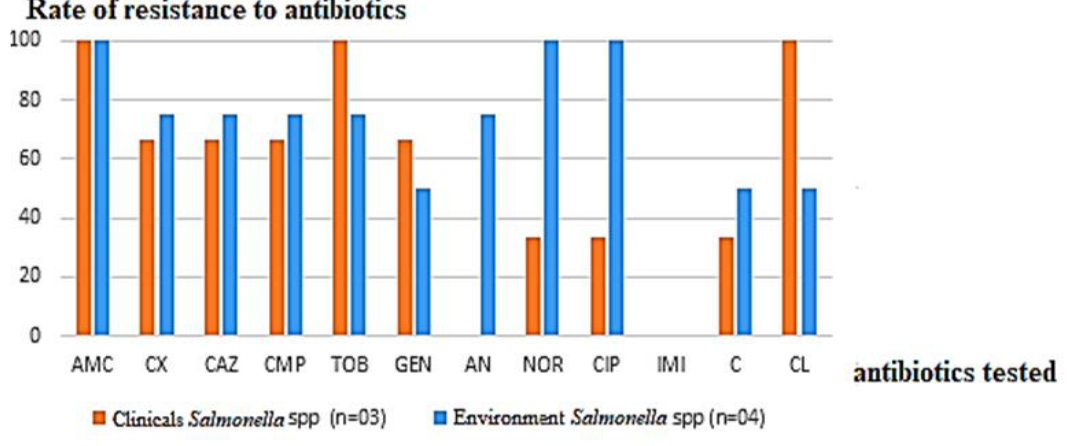
C : Resistance profile of Salmonella spp